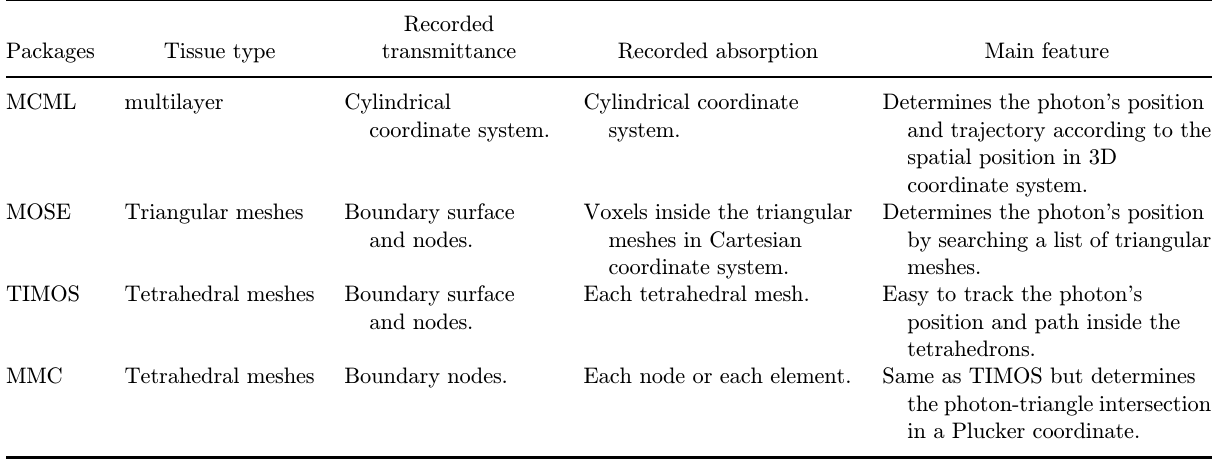
Table 1. Summary of MC-based simulation packages for light